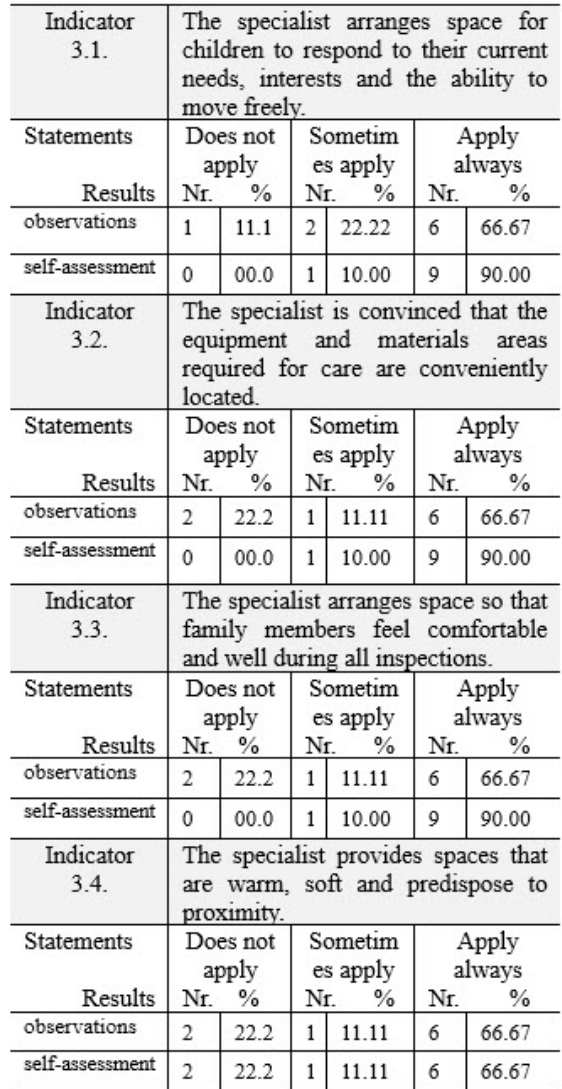
Table 28. Principle 3: The environment is hospitable, accessible and comfortable.